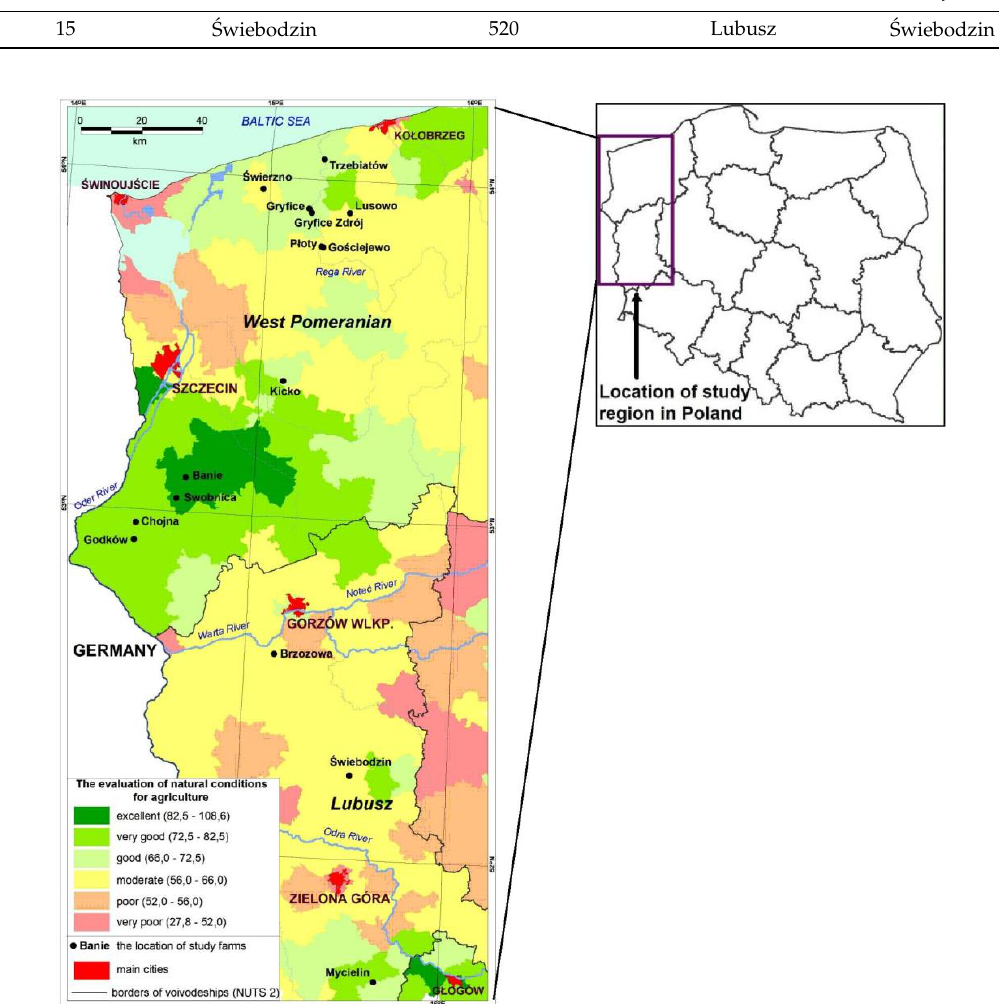
Figure 1. Location of study farms against the background of agricultural production space (Source: Authors based on [12,13]).